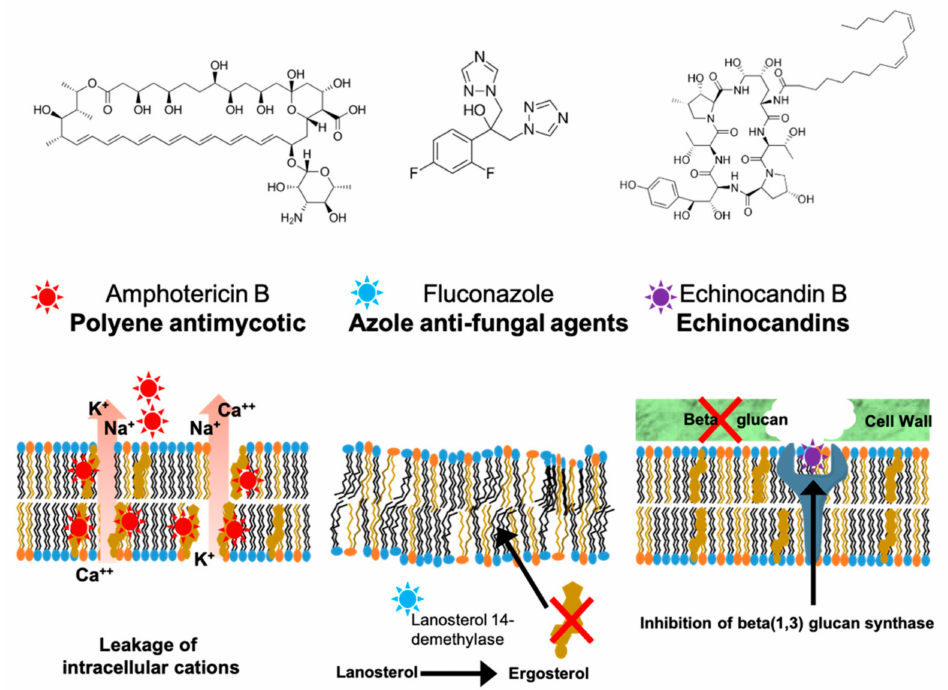
Figure 2. The major classes of antifungal drugs used in the clinic and their mechanisms of action. Panel illustrates available classes of anti-fungal therapeutics, polyenes ( left ), azoles ( middle ), and echinocandins ( right ). Their corresponding mechanisms of action are illustrated at